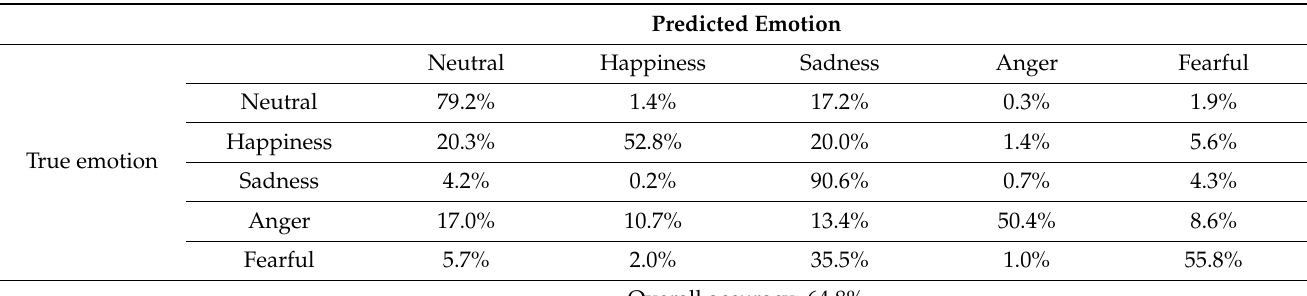
Table 7. Confusion matrix of the emotion classification results of the proposed cascaded DnCNN–CNN that was trained on the Korean CADKES mixed with the TMETRO